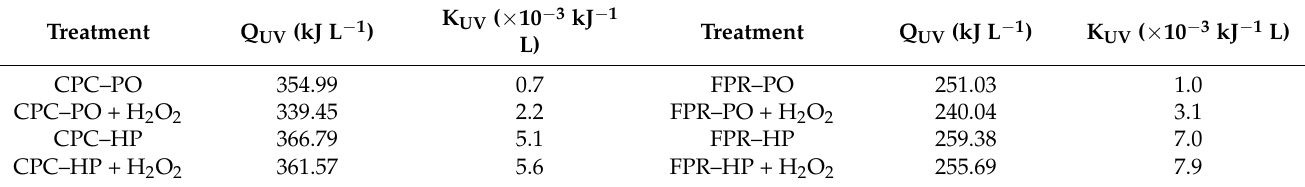
Table 7. Fluence and calculated reaction rate constants in function of fluence.